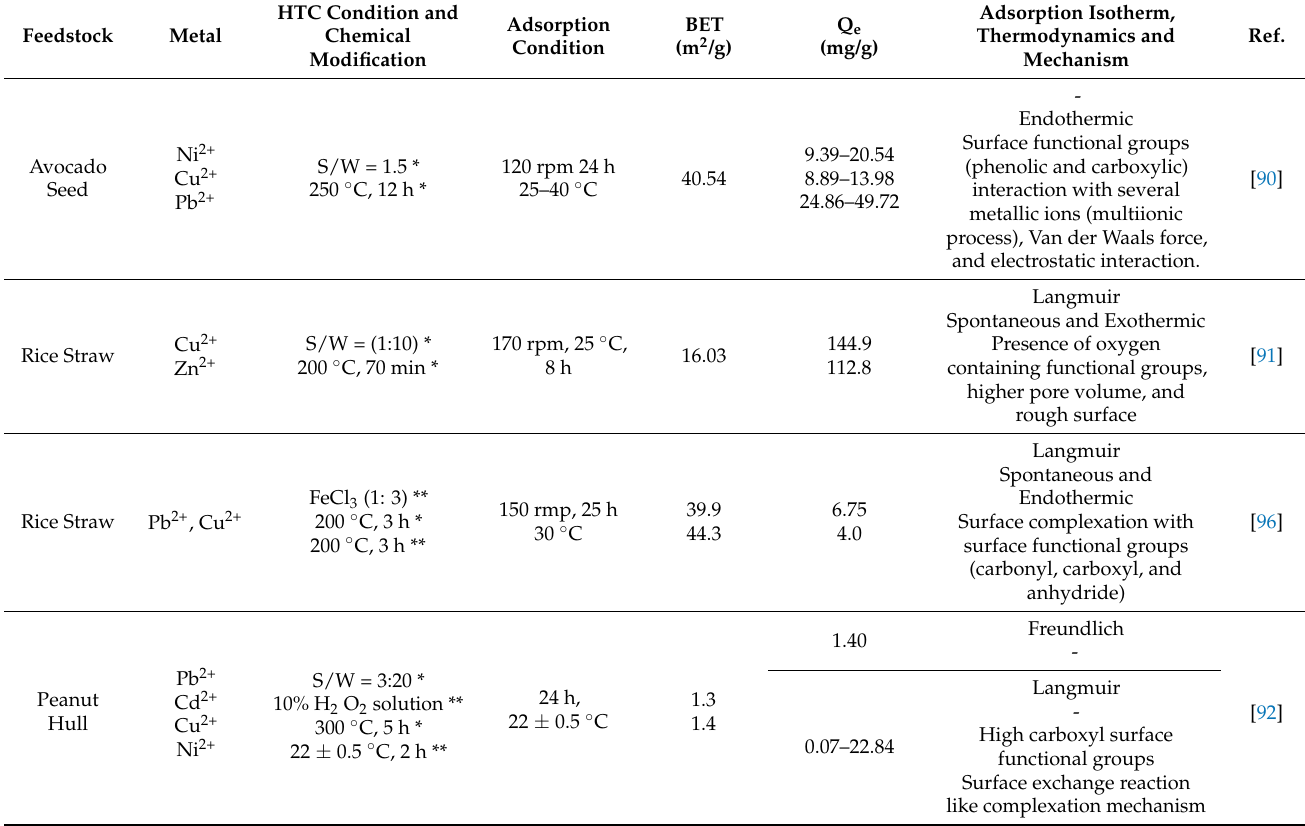
Table 3. Heavy metal adsorption by